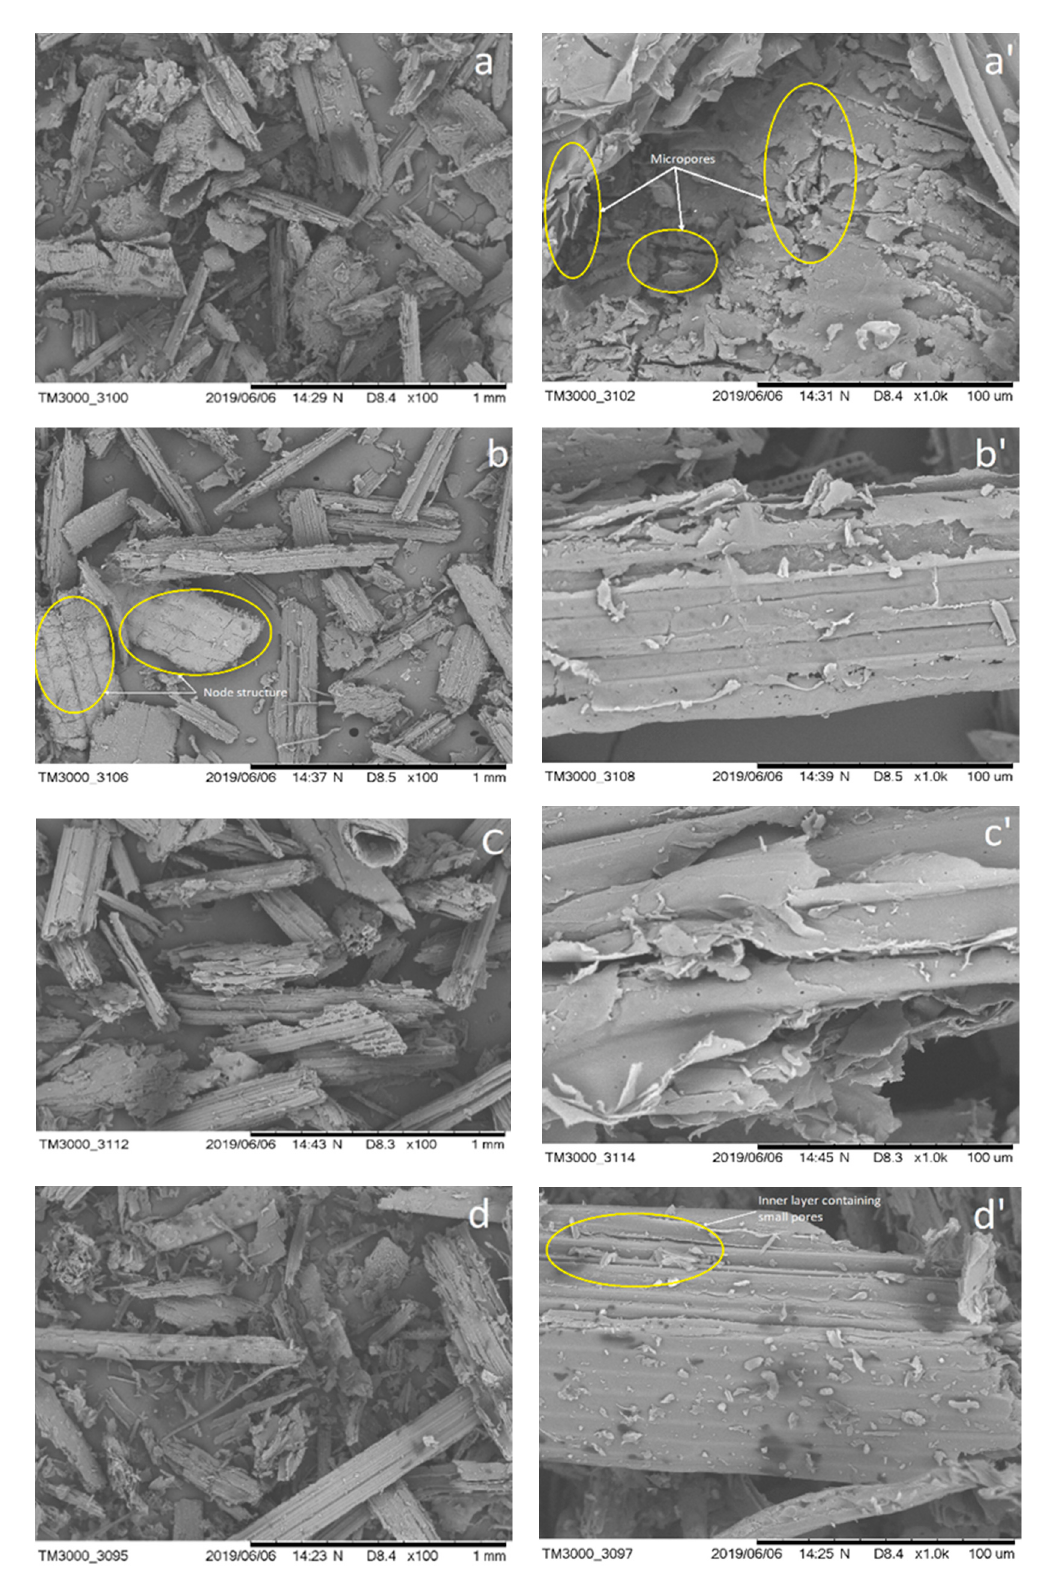
Figure 4. Morphologies of the Indigenous cow dung fiber ( a , a’ ), Jersey cow dung fiber ( b , b’ ), Buffalo dung fiber ( c , c’ ) and wheat straw ( d , d’ ) Left side: ×100, Right side: ×1000.